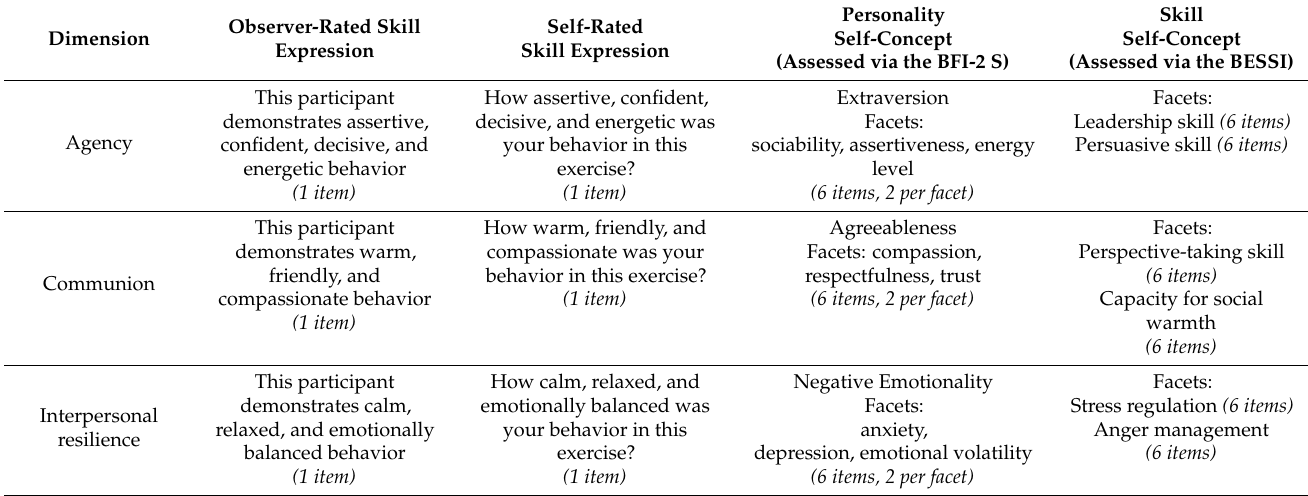
Table 1. Dimensions and Corresponding Skill Expression Ratings and